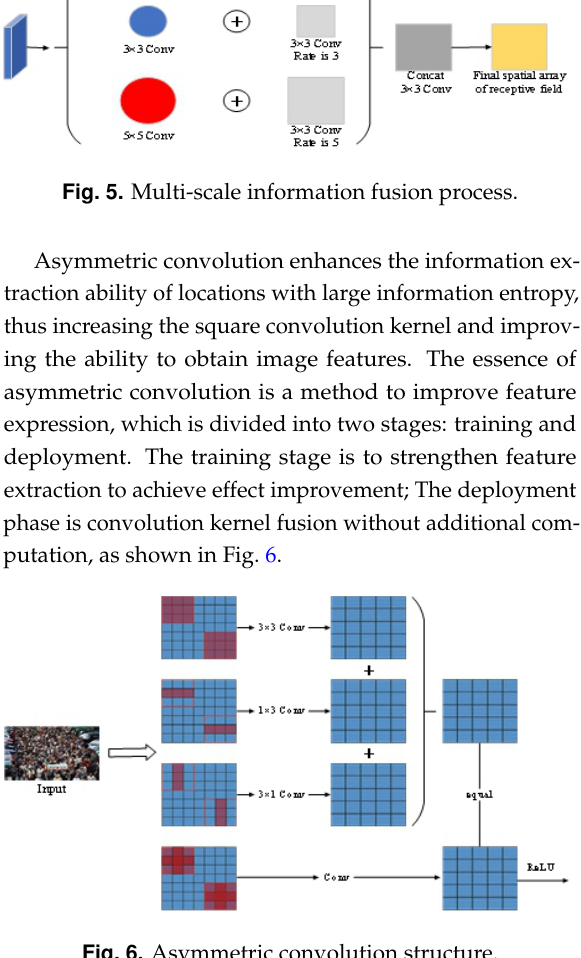
Fig. 6. Asymmetric convolution